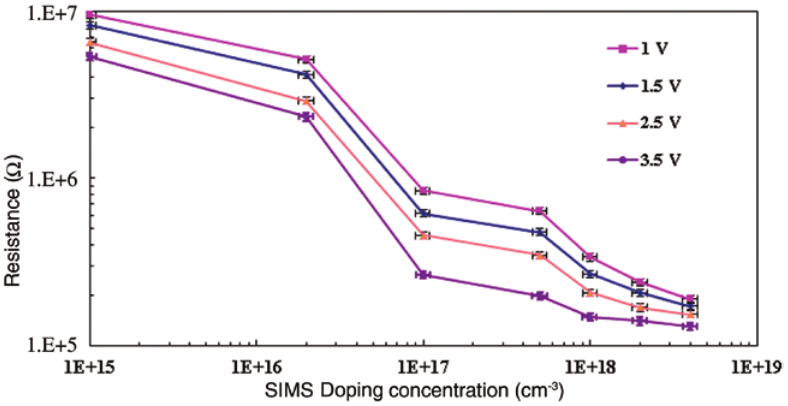
tively. As expected, the SSRM resistance monotonically